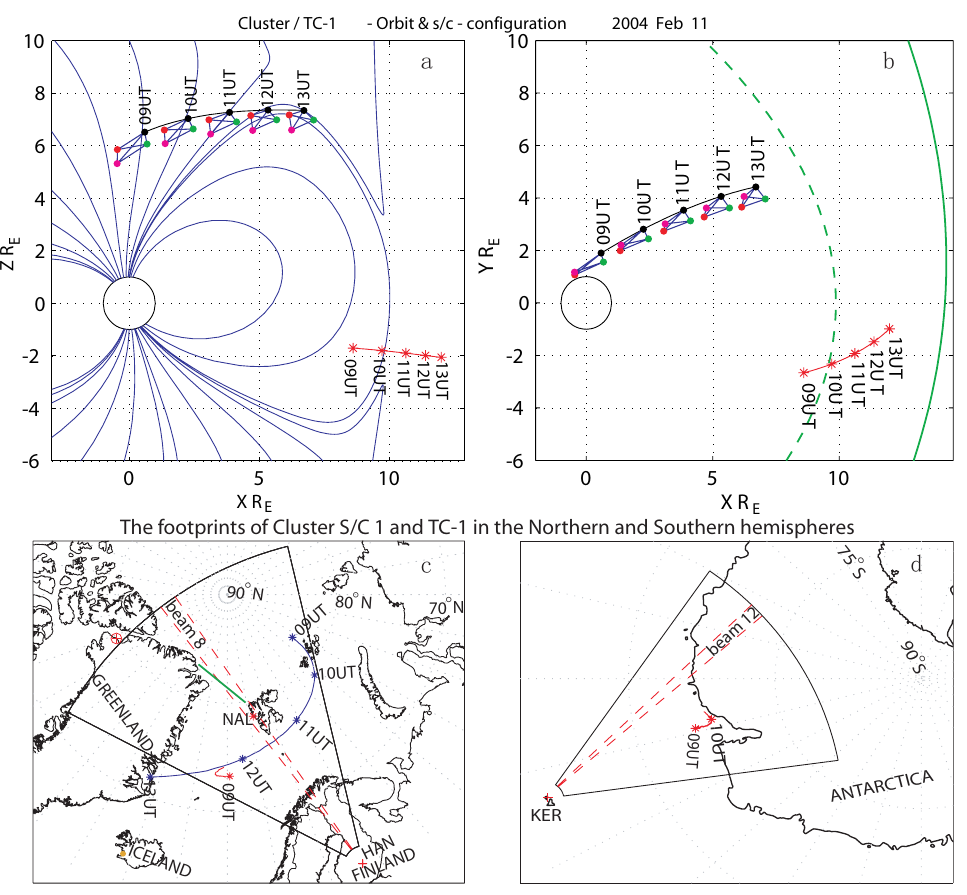
Fig. 2. All Cluster and TC-1 spacecraft tracks in the X-Z (a) and X-Y (b) plane in GSM coordinates, together with the ionospheric footprints of Cluster S/C 1 (blue line) and TC-1 spacecraft (red line) on the maps of Northern (c) and Southern (d) Hemispheres, between 09:00 and 13:00UT on 11 February 2004. The orbit also shows the configuration of the Cluster spacecraft array as a tetrahedron (size scaled up by a factor of 20). The Model geomagnetic field lines are shown for the projection into the X-Z plane and cuts through the bow shock and magnetopause are shown for the X-Y plane. The X-Z plane field lines and ionospheric footprints of the spacecraft are drawn from the Tsyganenko ’96 model inputting the real parameters. The field-of-view of the CUTLASS Finland radar and Kerguelen radar is presented as a fan in panels (c) and (d) , respectively, with the beams employed in this study indicated by red dashed lines. The poleward-looking low elevation beam (32M dish) of ESR (between 76 and 85 ◦ magnetic latitude) is indicated by the solid green line. The red“ ⊕ ” presents the magnetic